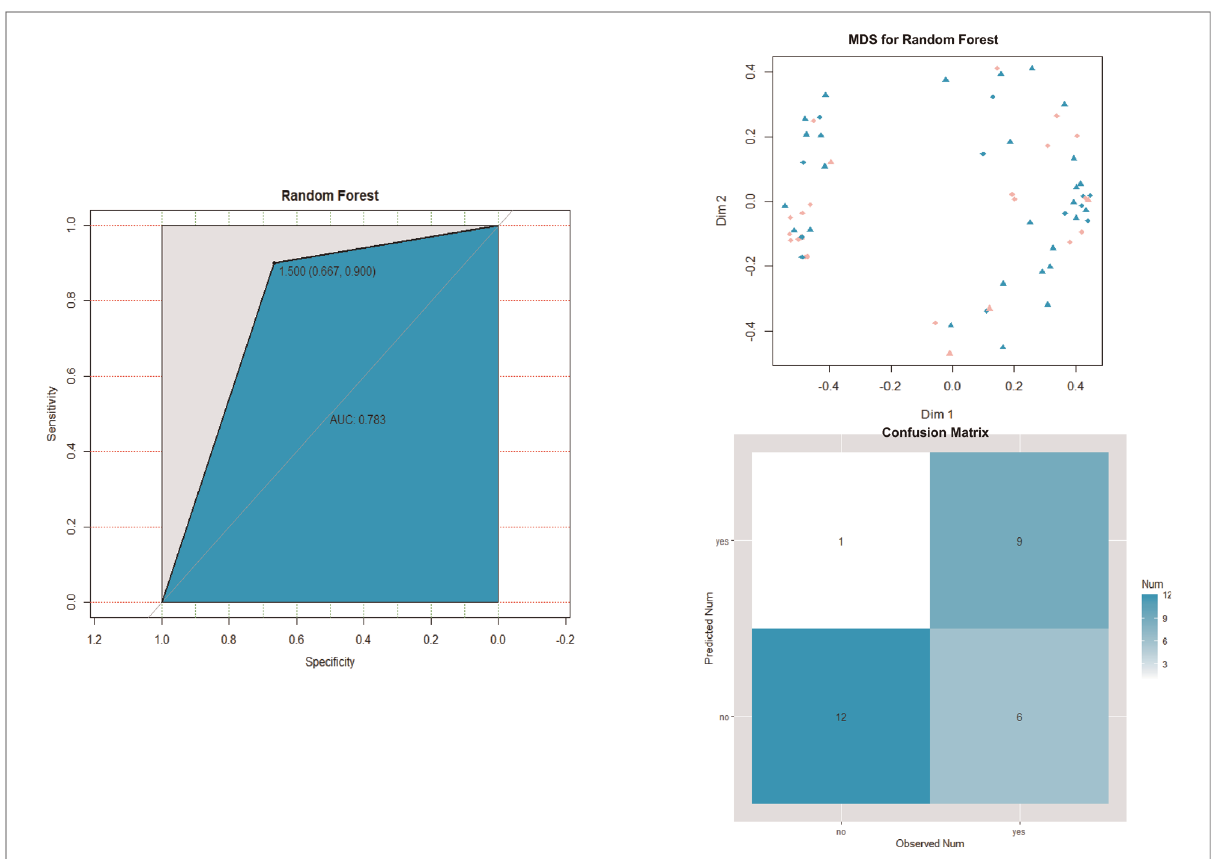
FIGURE 7 Roc curve, MDS plot and predicted result of the fi nal random forest model for CPSP risk in Set 2. MDS, multidimensional